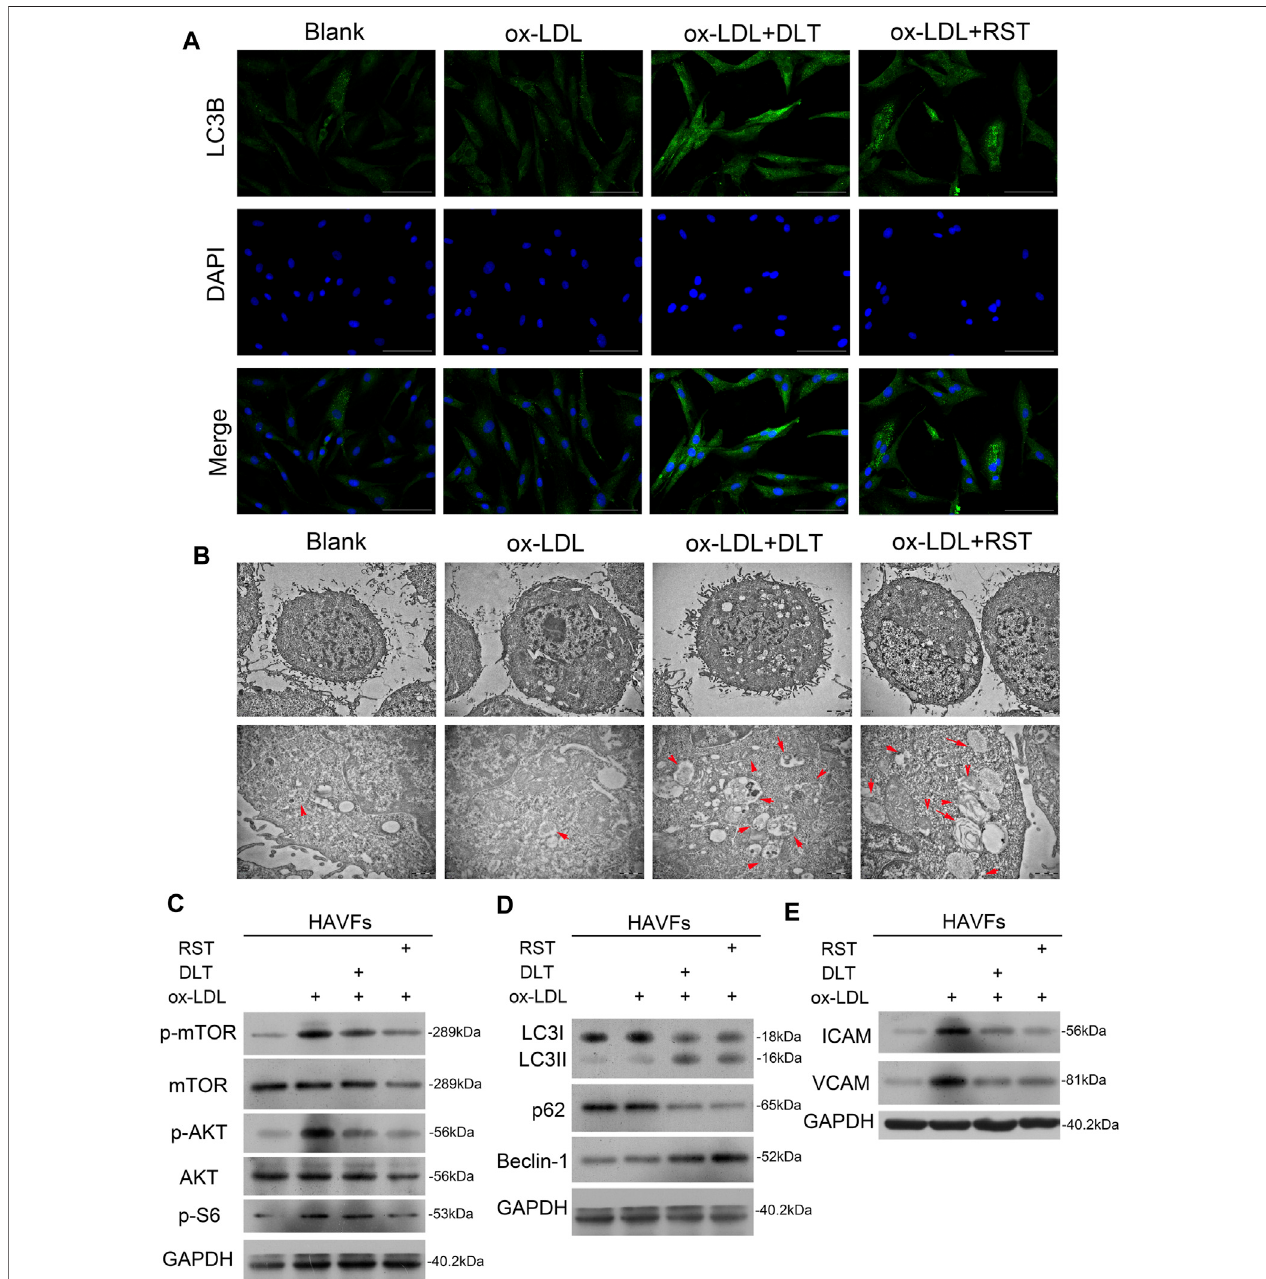
FIGURE 4 | DLT activates the autophagy pathway in HVAFs through the PI3K/Akt-mTOR pathway. (A) Immuno fl uorescence staining of LC3 to show the activation of autophagy in the DLT treatment group. (B) Transmission electron microscopy analysis to show the autophagosome in the DLT treatment group (red arrow). (C) Western blot showed DLT treatment reversed the ox-LDL-induced activation of the PI3K/Akt-mTOR pathway. (D) The autophagy marker expression was detected by western blotting and increased in the DLT treatment model. (E) The HVAFs activation markers ICAM-1 and VCAM-1 were checked in the DLT-treated and ox-LDL model.